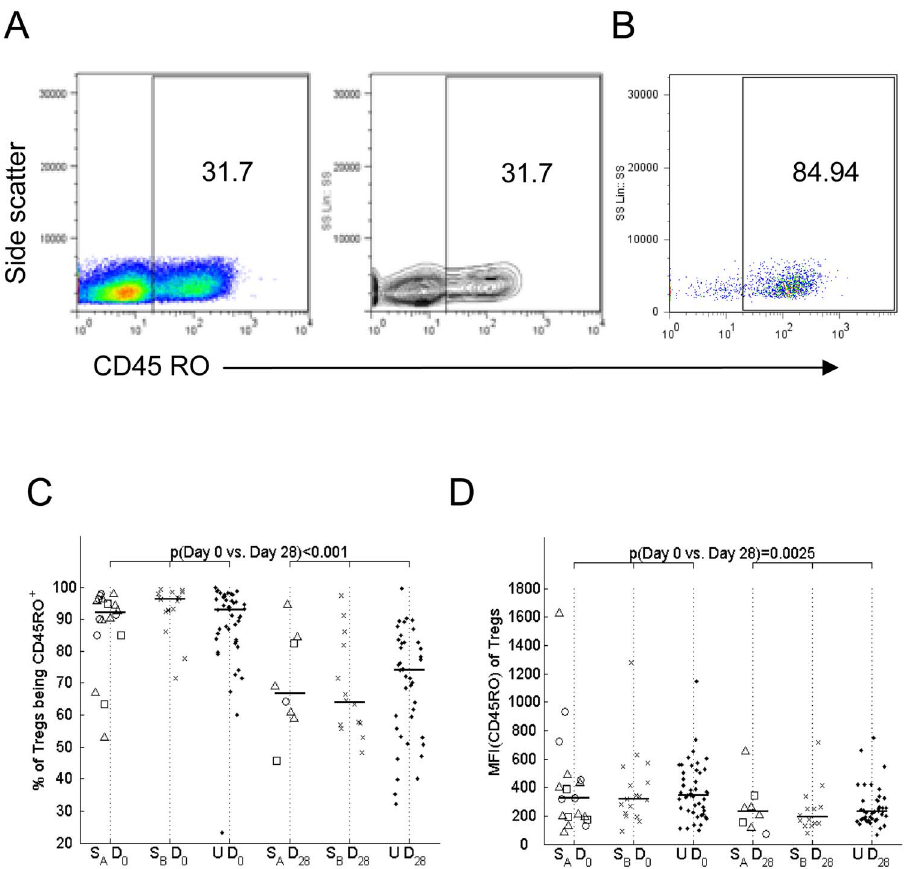
Figure 3. Tregs display an activated memory phenotype during acute disease. (A) Defining the gate for CD45RO staining on CD3 + PBMC using the contour display. (B) CD3 + CD4 + FOXP3 + CD127 2 /low PBMC displayed according to CD45RO expression using the gate defined in (A). (C) percentage of CD3 + CD4 + FOXP3 + CD127 2 /low PBMC expressing CD45RO. (D) Median Fluorescence Intensity (MFI) for CD45RO staining on CD3 + CD4 + FOXP3 + CD127 2 /low PBMC. Symbols, bars and p-values as defined in Figure 1.